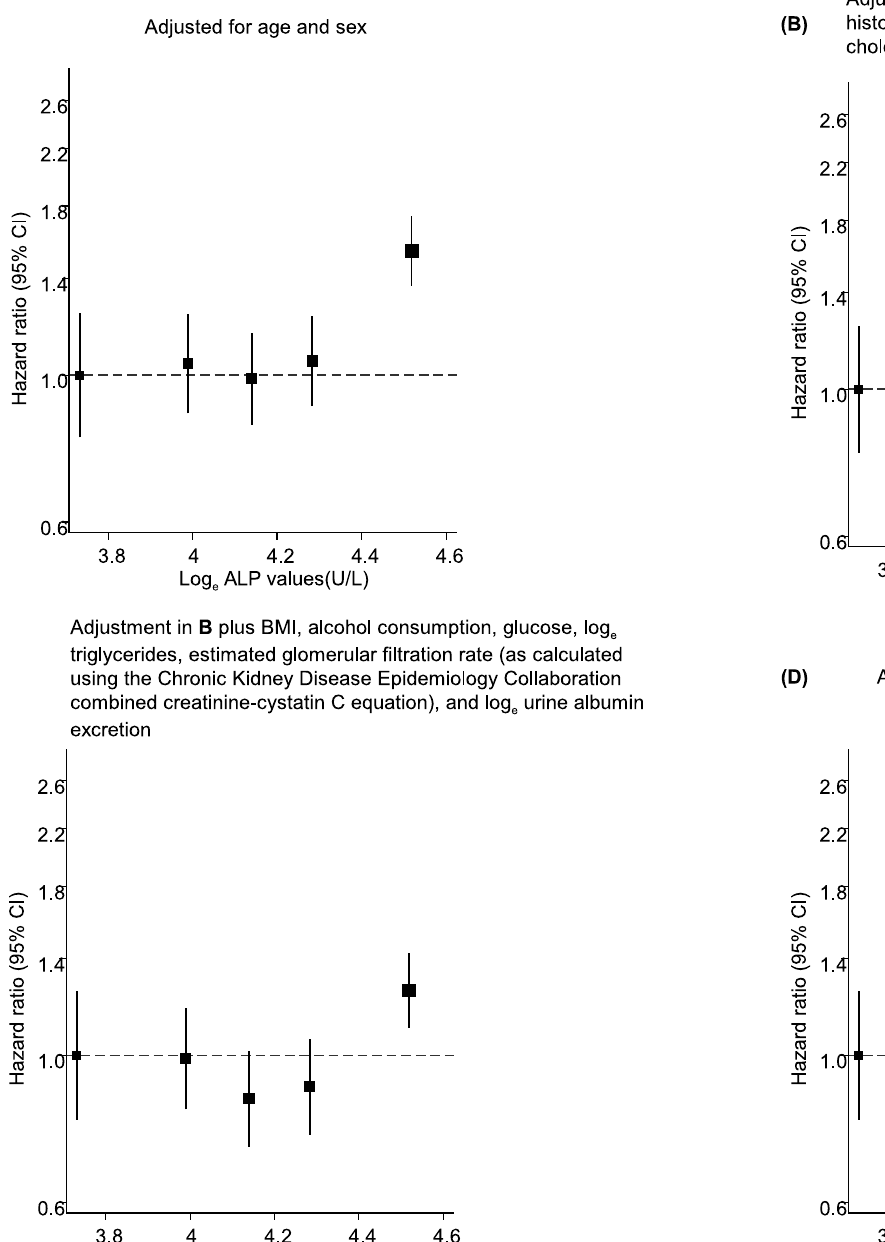
PLOS ONE | DOI:10.1371/journal.pone.0132822 July 13,